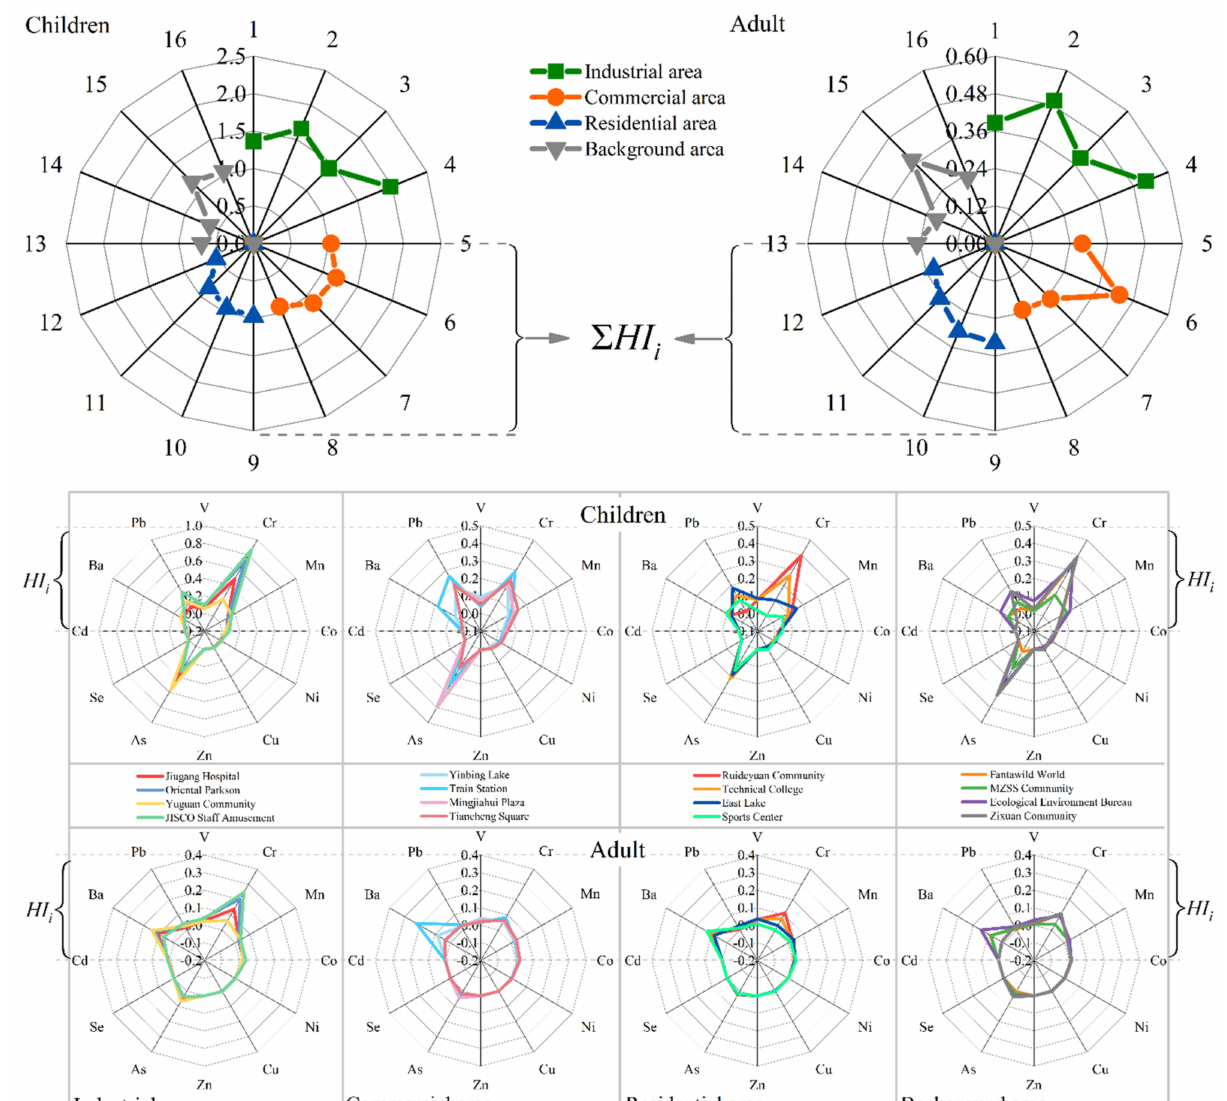
Figure 5. Characterization results for non-carcinogenic